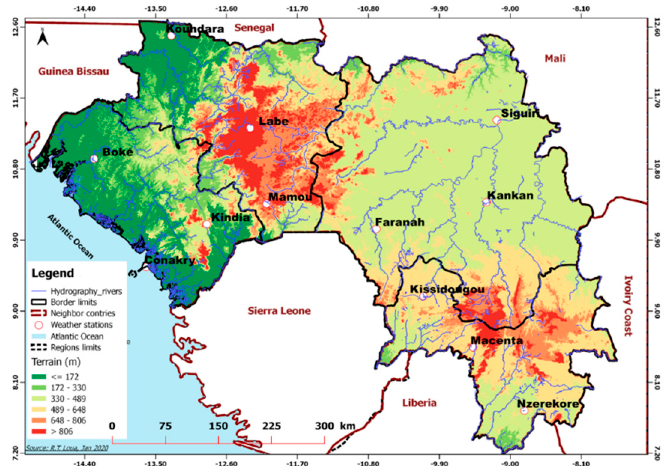
Figure 1. Geographical location of 12 weather stations used in the present study (circle symbols) along with elevation (in meters in ground color according to the legend) in the four natural regions of Guinea. Edited by Loua R.T. 02/2020.